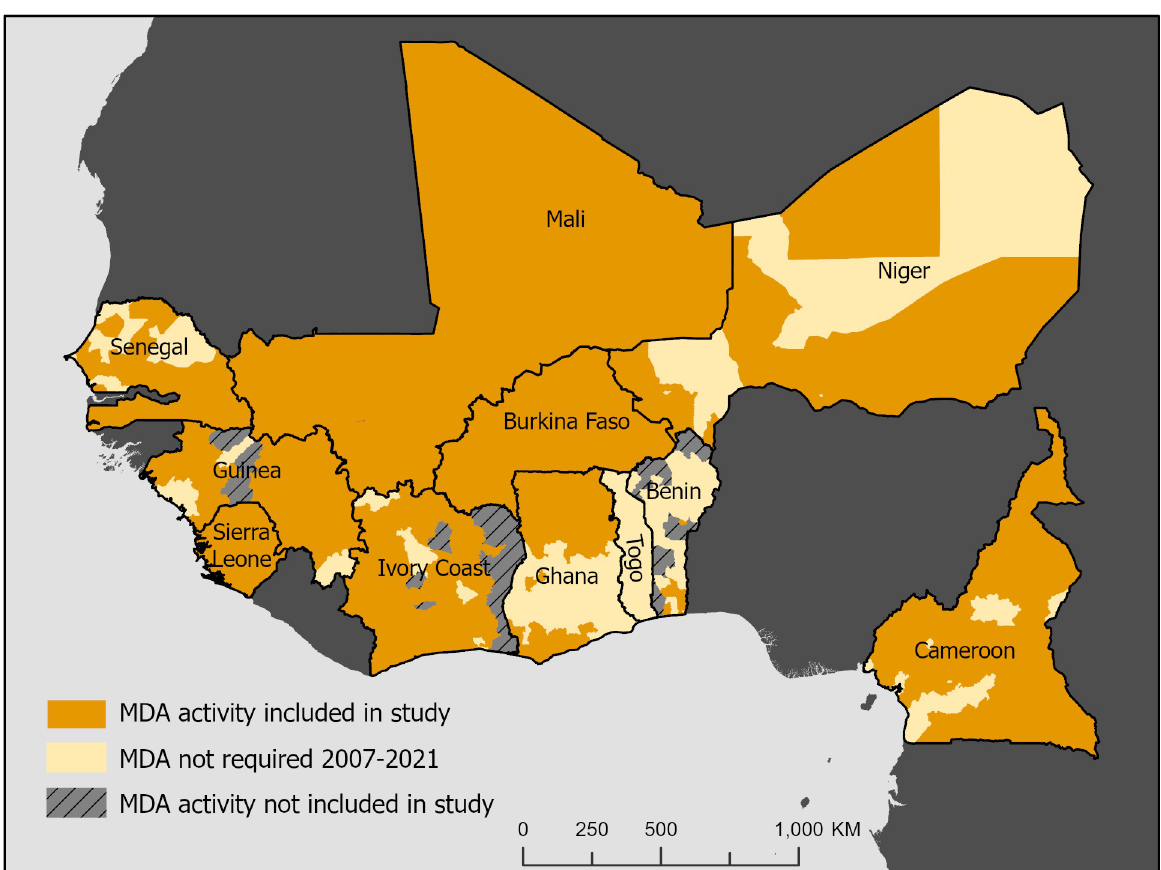
Fig 1. Geographical distribution of LF MDA data included in study. Created using a base layer from the Database of Global Administrative Areas (GADM) (source: https://gadm.org/download_world.html).